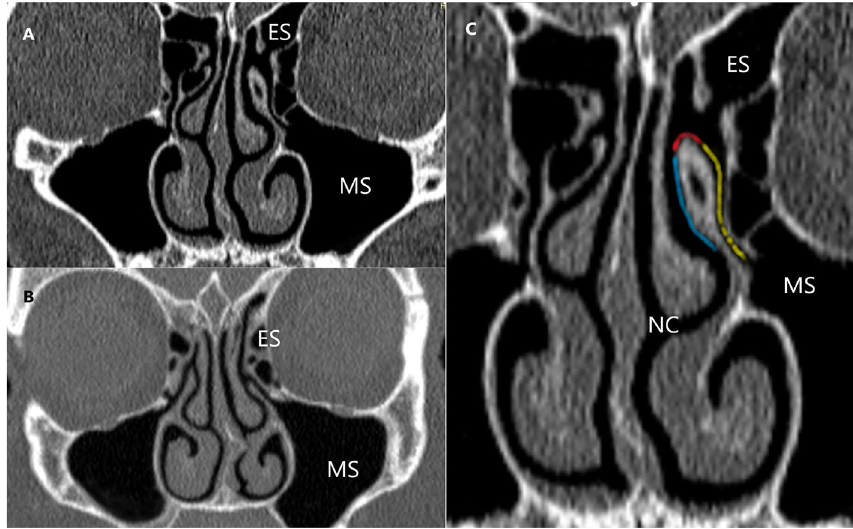
Figure 2. CT scans of nasal sinuses (ES—ethmoid sinus; MS—maxillar sinus; NC—nasal cavity): ( A ) Patient 1 (normal anatomy); ( B ) Patient 2 with nasal obstruction and nasal septum deviation (NSD) to the left side; ( C ) sinus surface of the ethmoid bone uncinate process (SUP) (yellow), the nasal surface of the ethmoid bone uncinate process (NUP) (blue); apex of the ethmoid bone uncinate process (AUP)